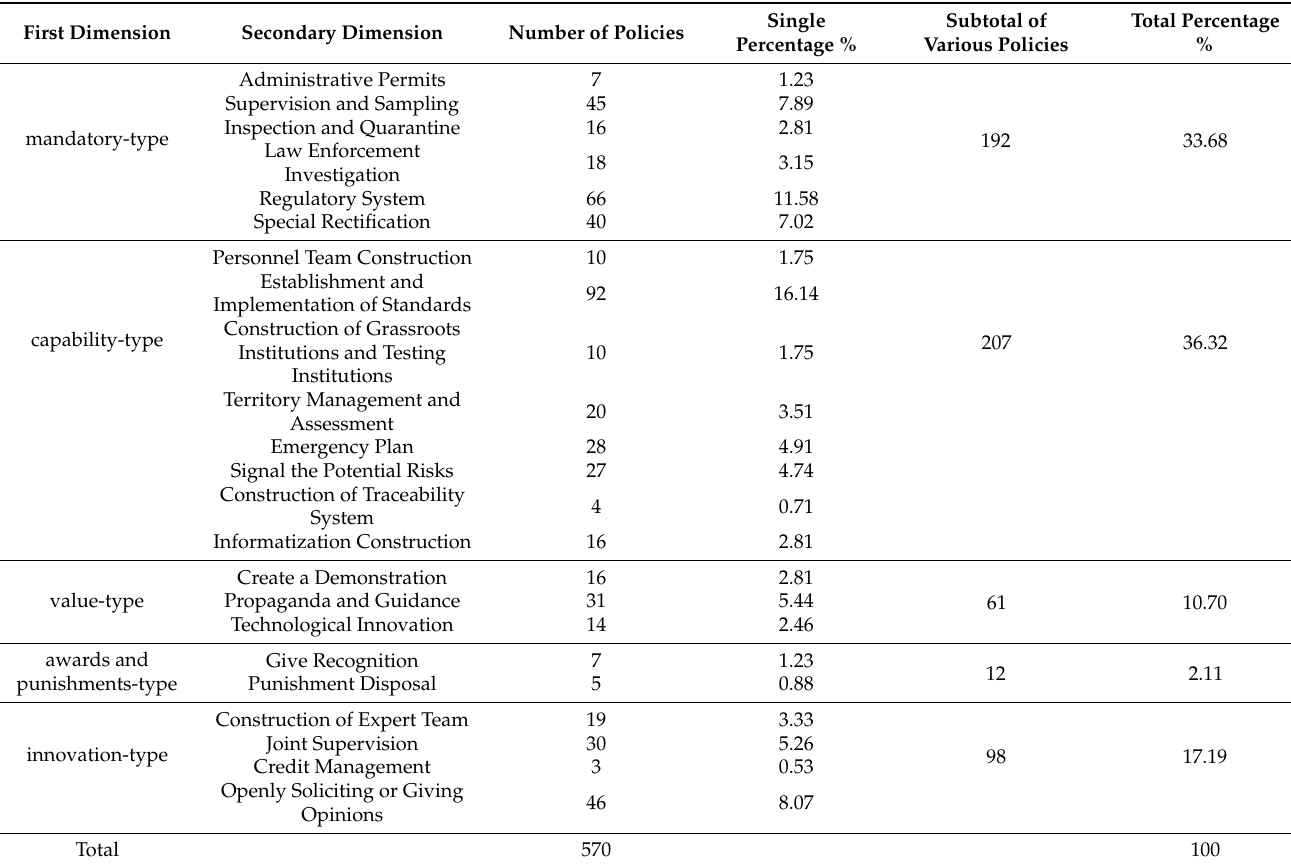
Table 5. Statistics on the number and proportion of various